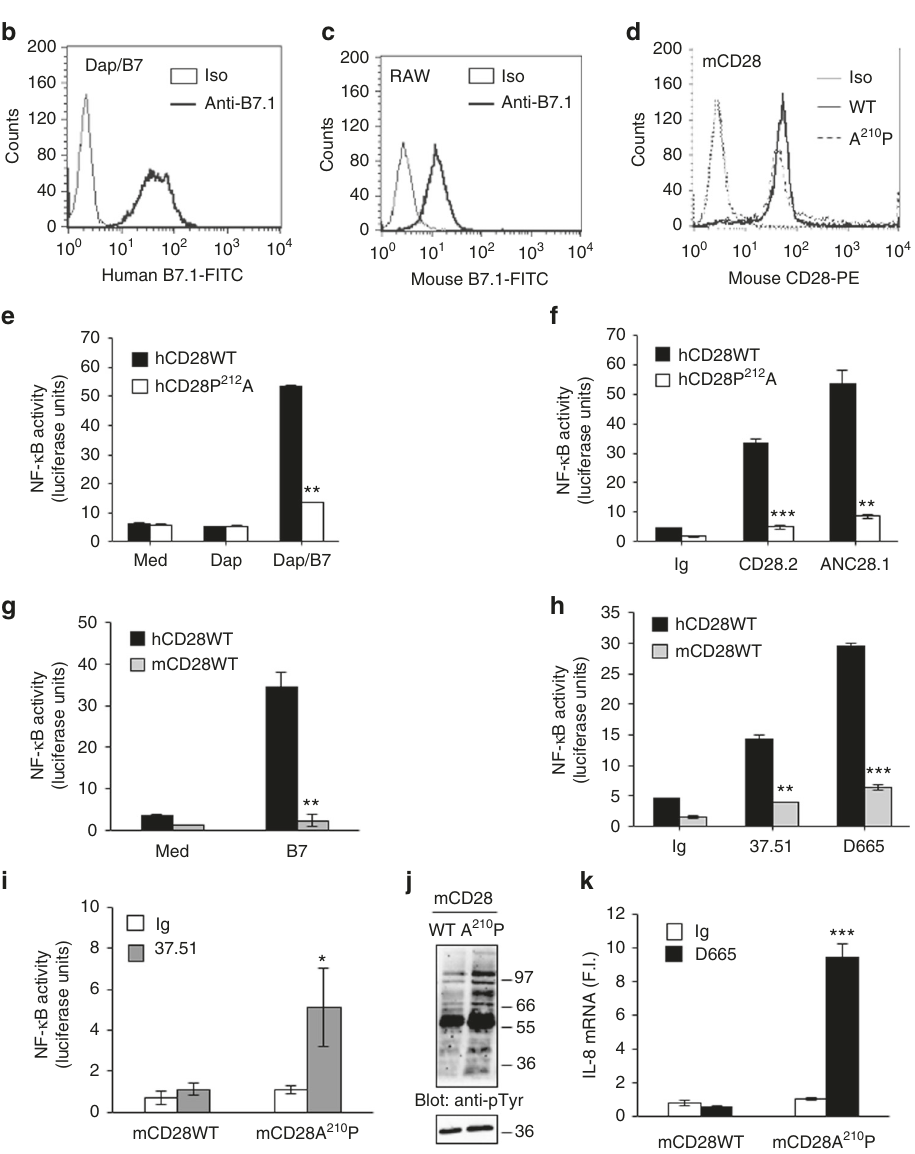
Fig. 4 P 212 A substitution within the C-terminal proline-rich motif (YQPP 212 ) of CD28 impairs NF- κ B activation. a Amino acid sequence of mouse CD28 WT (mCD28WT) and mCD28 A 210 P mutant. The substitution A 210 P in mCD28 is indicated in bold. b – d FACS analysis of Dap3 cells transfected with human B7.1 (Dap/B7) ( b ) or mouse RAW 264.7 cells (Raw) ( c ) stained with FITC-conjugated isotype control (Iso) or anti-B7.1 Abs, or CH7C17 cells transfected with mouse CD28 (mCD28) WT or mCD28 A210P mutant stained with phycoerythrin (PE)-conjugated isotype control (Iso) or anti-CD28 (CD28-PE)